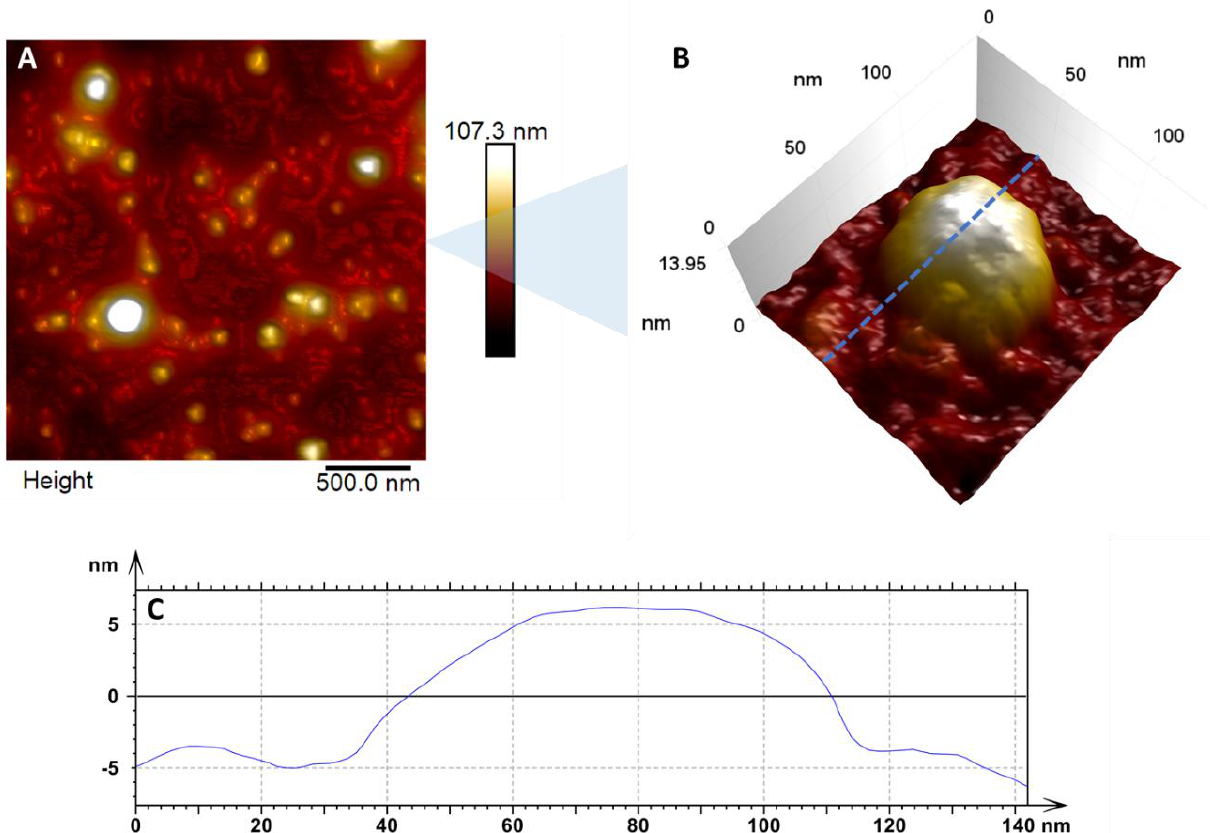
Figure 1. In ( A ) we have the enlarged topographic image of countless viral particles dispersed in the substrate, with a diameter varying between 47 nm and 69 nm. ( B ) Zoom of the surface of a single viral particle showing the details of the virus structure. The blue dashed line indicates the region where the cross-section shown in ( C ) was taken. ( C ) Cross-section of an adsorbed ZIKV particle in a glass substrate.